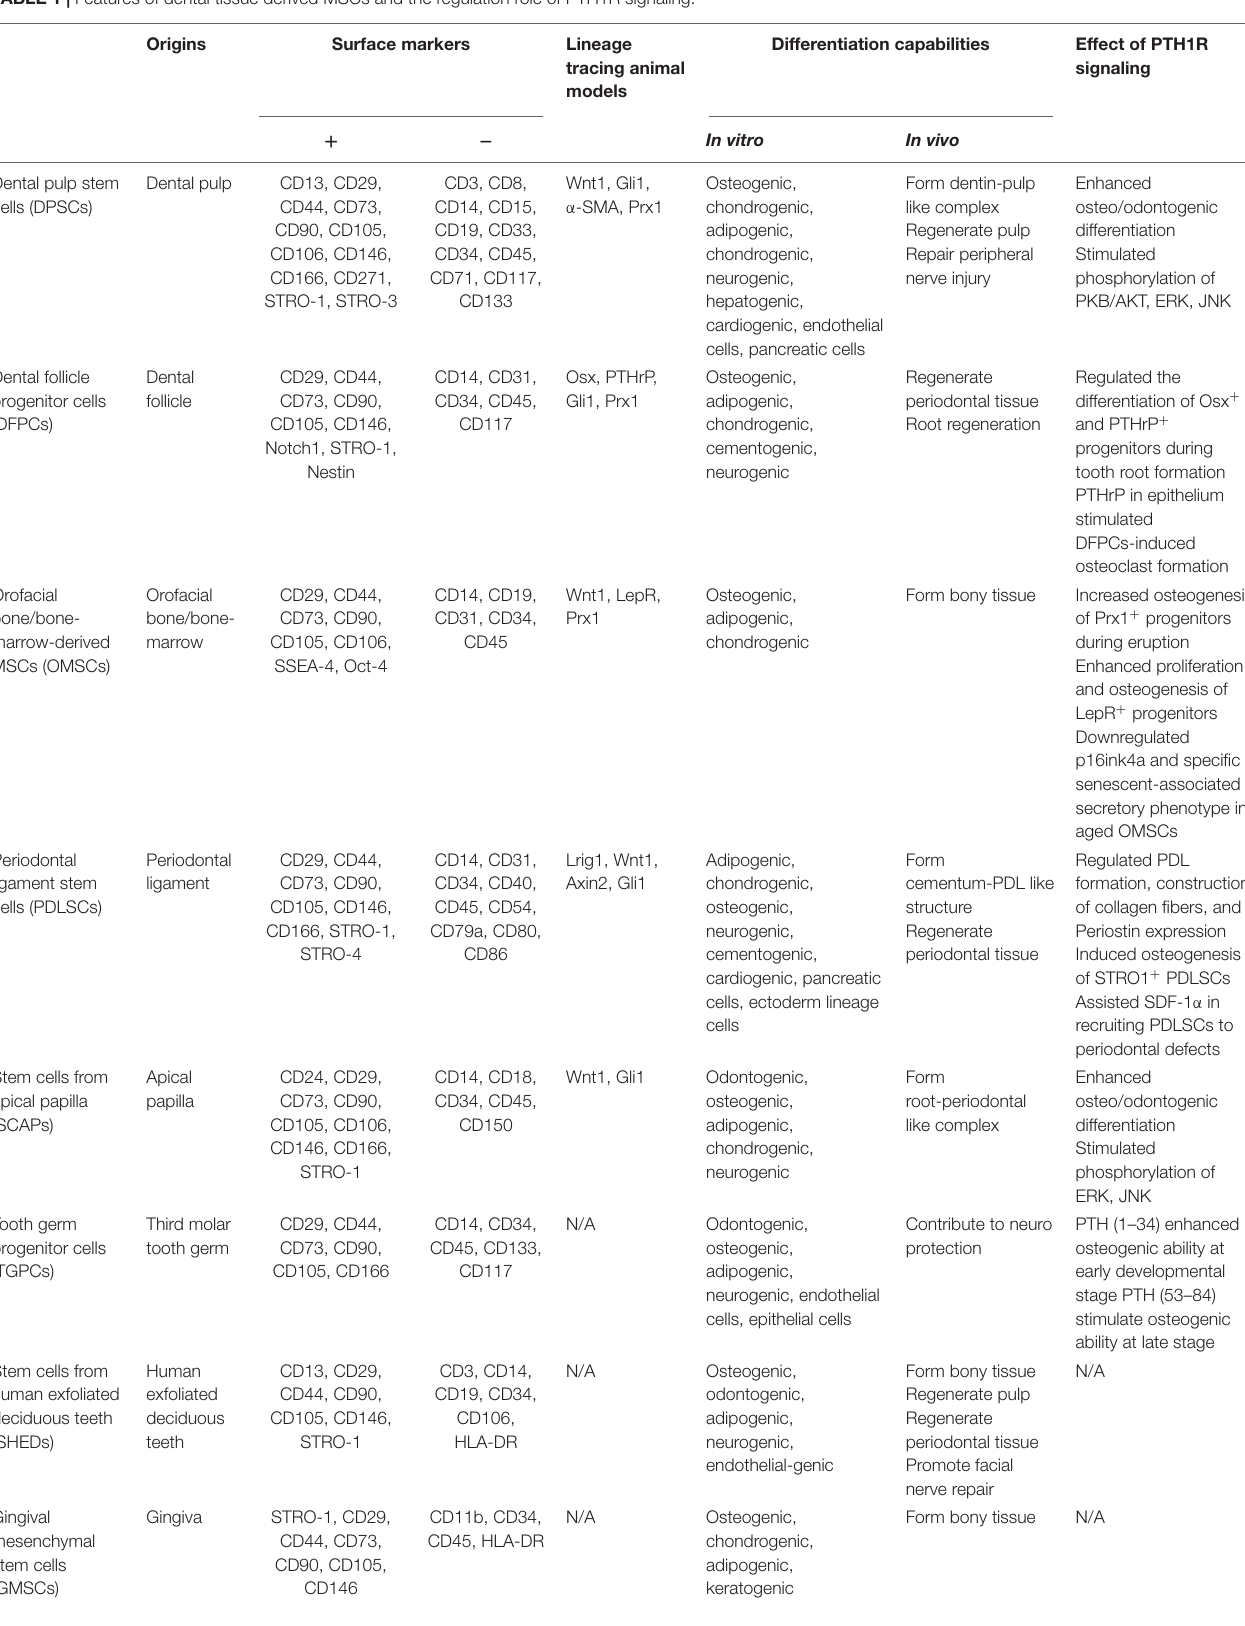
TABLE 1 | Features of dental tissue derived MSCs and the regulation role of PTH1R